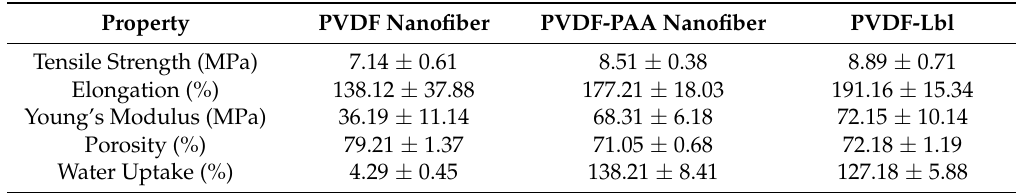
Table 1. Mechanical properties and porosity of the plain PVDF, PVDF-PAA, and PVDF-LbL nanofiber